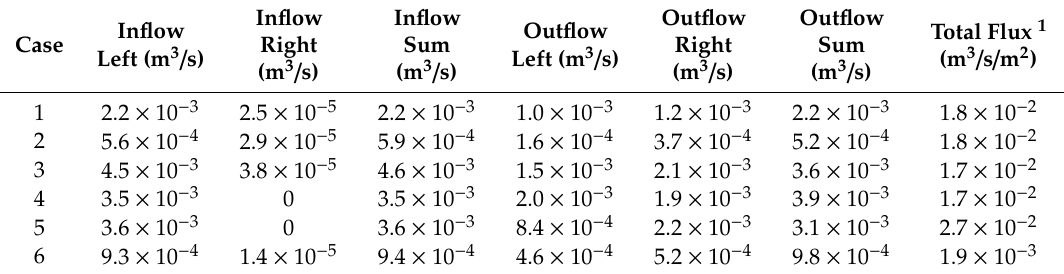
Table 3. Hyporheic fluxes of a single ripple in the center of a series of ripples for case 1–6 (gravel). Right and left indicate the part of the ripple right and left of the ripple crest (compare Figure 4).